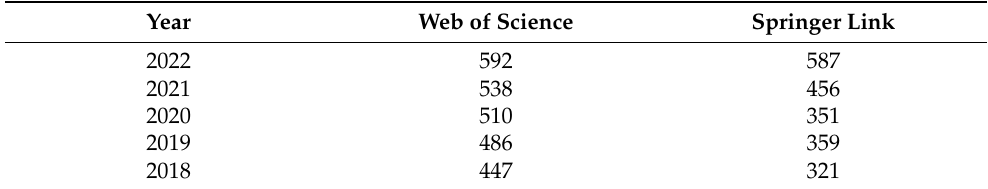
Table 1. Summary of the total number of scientific papers (research and review article, book chapter, conference paper) using “Hopkinson bar” as a keyword concerning dynamic experiments with samples of different materials from 2018 to 2022 according to the resources of the scientific databases Web of Science and Springer Link [26,27]. Year Web of Science Springer Link 2022 592